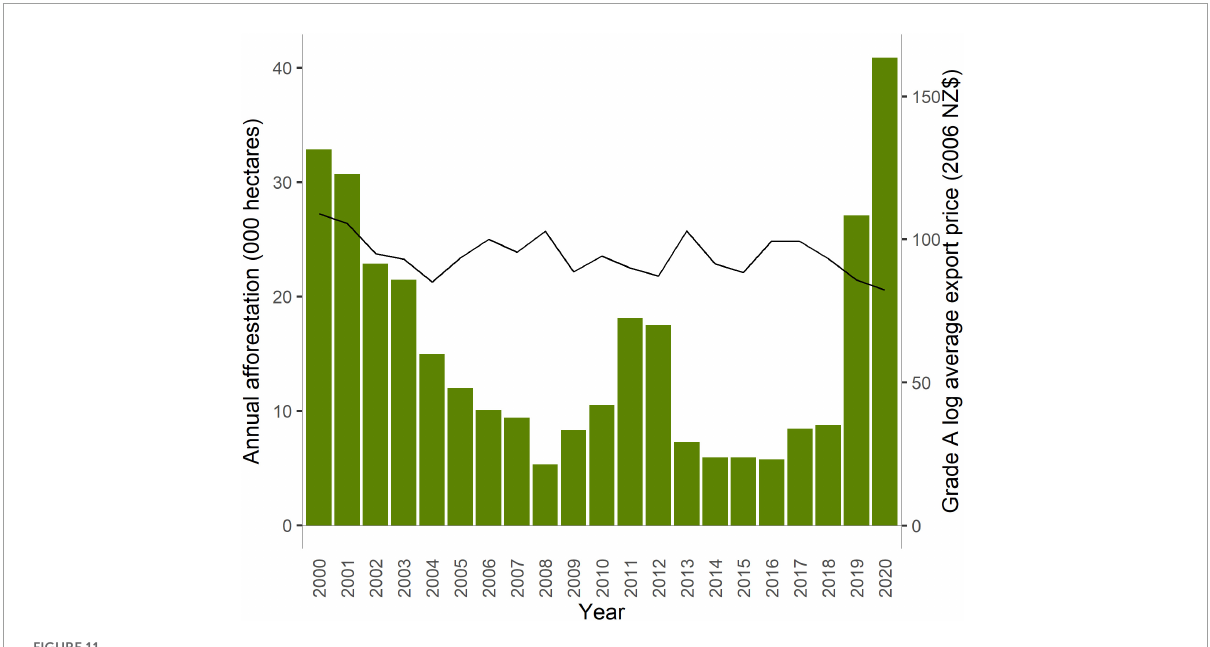
FIGURE11 Afforestation and Grade A log price. Data from MPI